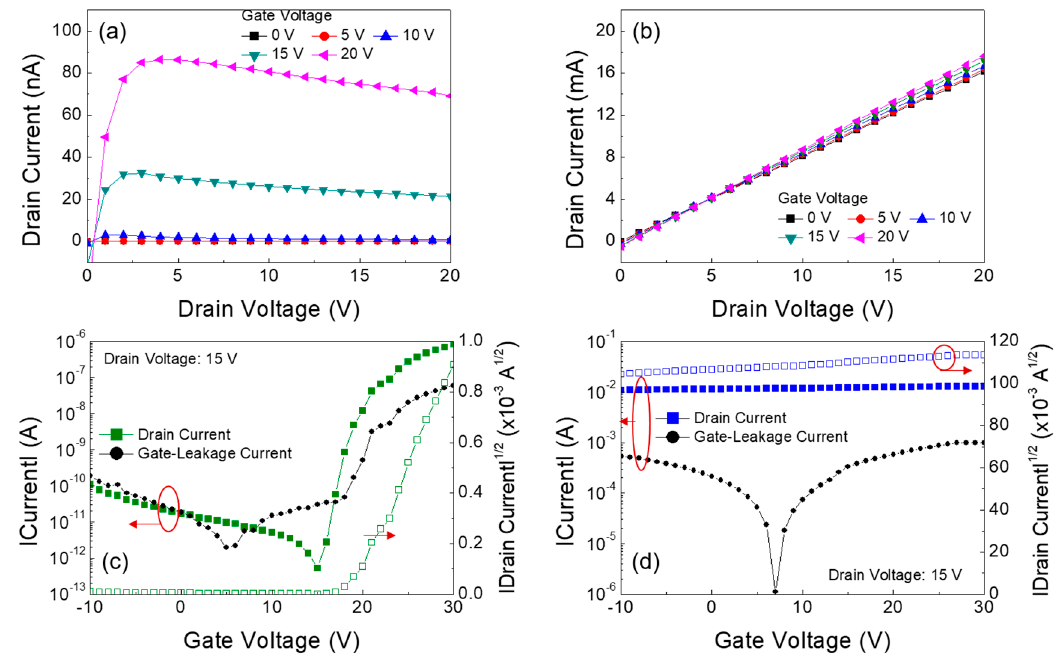
Figure 6. Output characteristics of the TFTs (thin-film transistors) fabricated with ( a ) Ga oxide and ( b ) Sn oxide films. Transfer characteristics of the TFTs fabricated with ( c ) Ga oxide and ( d ) Sn oxide films.